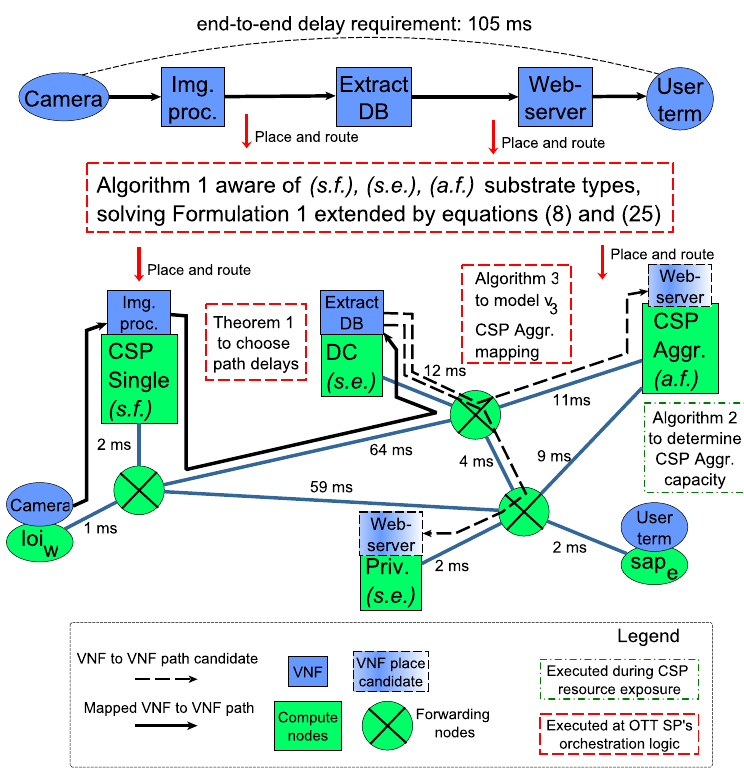
Figure 4. Illustration of applying the presented results in a 5G prototype architecture for the remote security camera analytics and alerts IoT